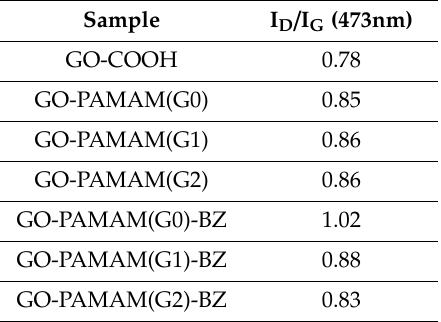
Table 2. The I D / I G ratio resulted from the Raman spectra of investigated Table 2. The I D /I G ratio resulted from the Raman spectra of investigated materials.